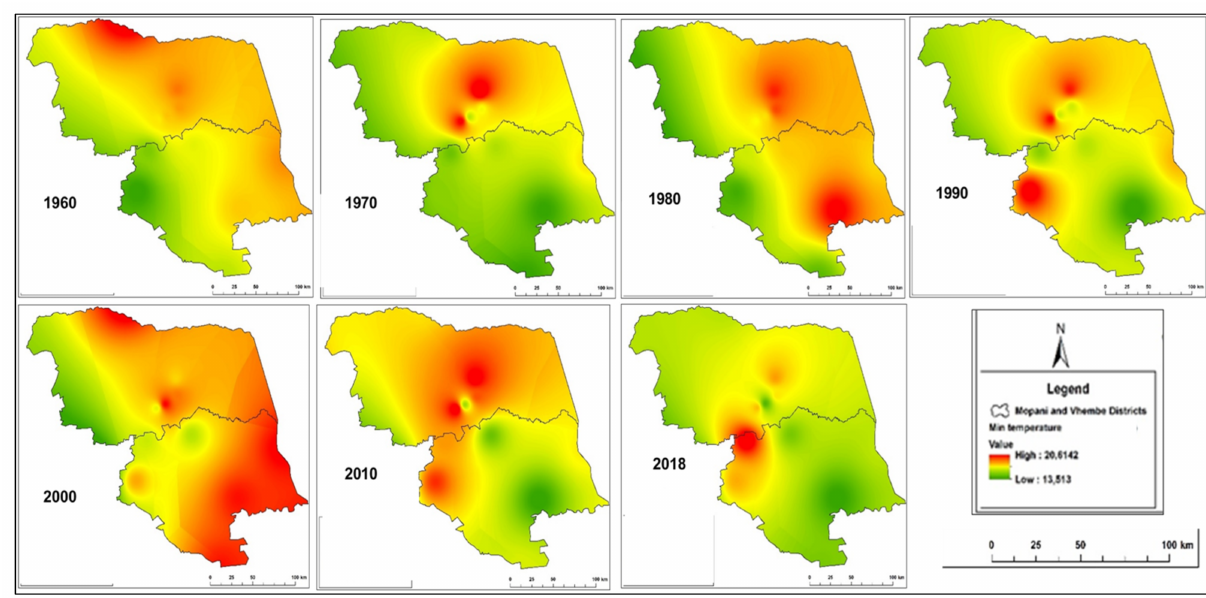
Figure 4. Minimum temperature for 1960, 1970, 1980, 1990, 2000, 2010, and 2018 in the Mopani and Vhembe